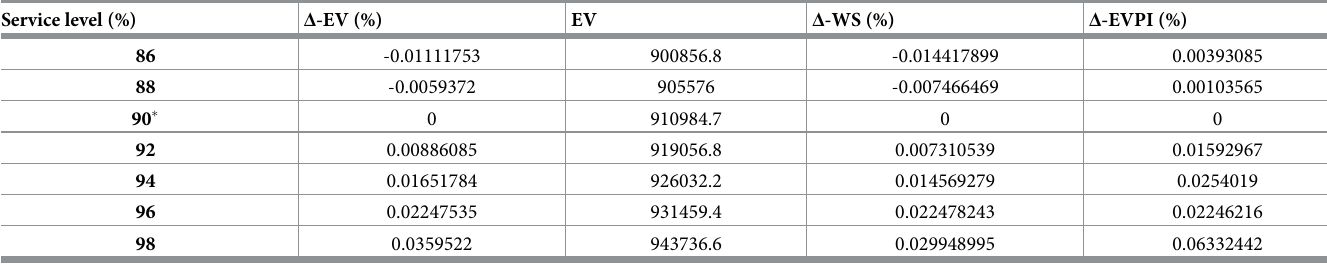
Table 10. Impact of the service level constraint in Model-I. Own elaboration.